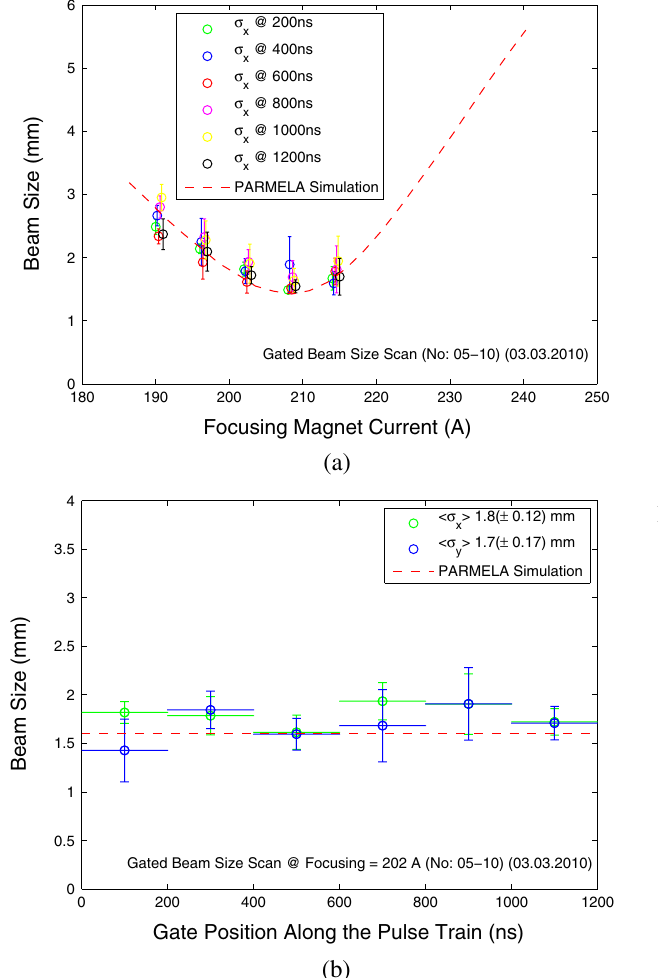
FIG. 10. Beam size scan along the bunch train for a beam of 1.4 nC, 4.9 MeV. (a) Horizontal beam size scan as a function of the focusing. (b) Representation of the measurement under a focusing current of 202 A as a function of the gate